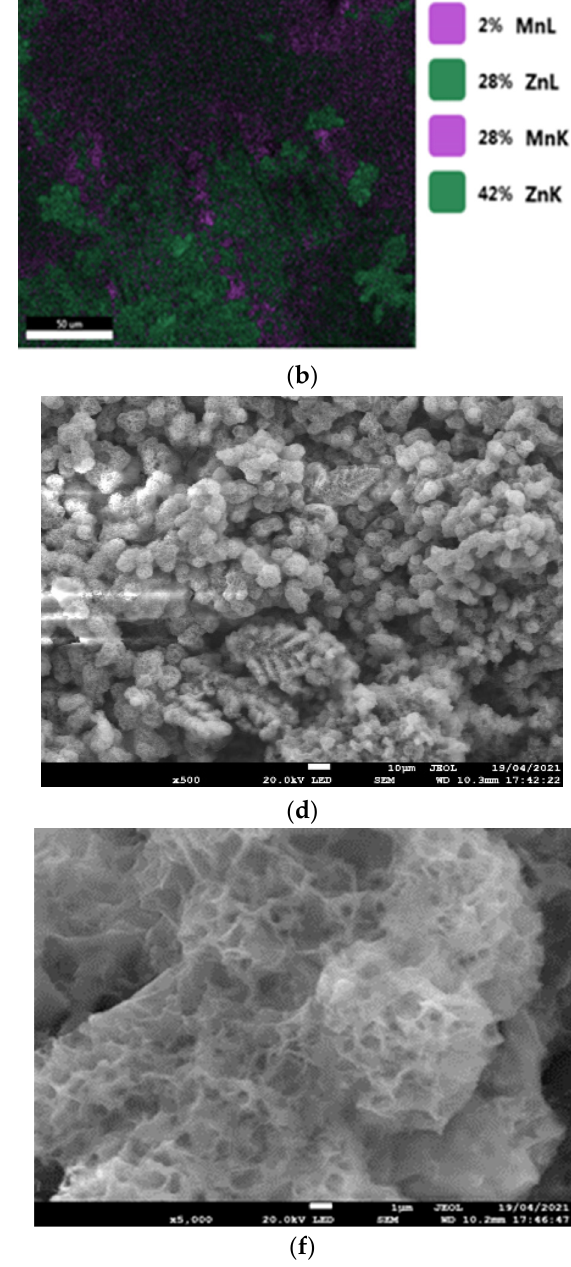
Figure 13. Morphologies of coatings elaborated for B = 0.3 T and for E = − 1.8 V/SCE, before immersion (( a ) imagex500, ( b ) mapping, and ( c ) imagex5000 and after immersion for 2 h in 35 g/L NaCl (( d ) imagex500, ( e ) mapping, and ( f ) imagex5000).